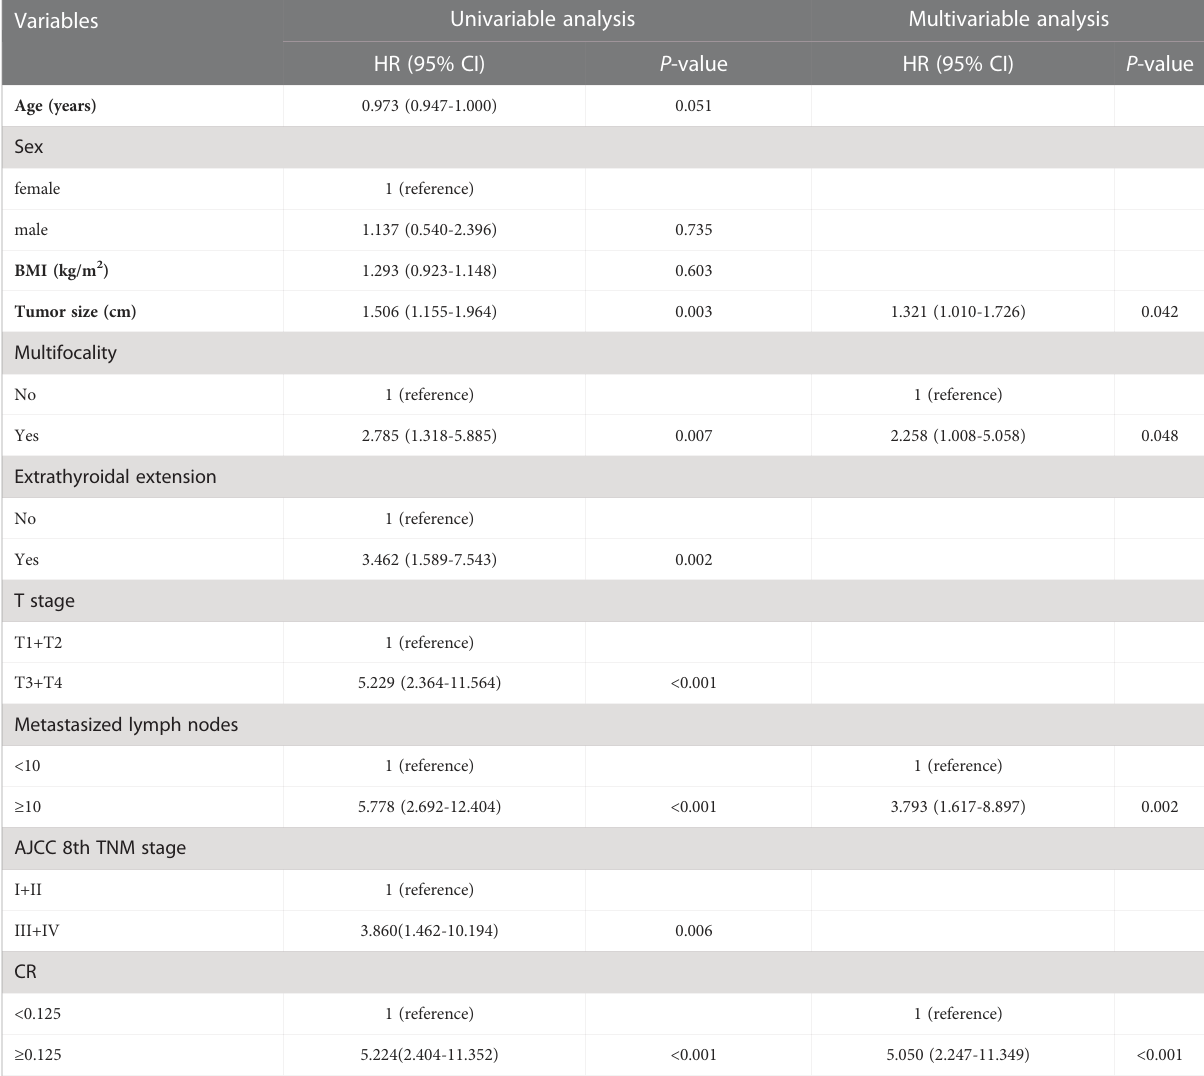
TABLE 2 Univariate and multivariate Cox analysis for recurrence-free